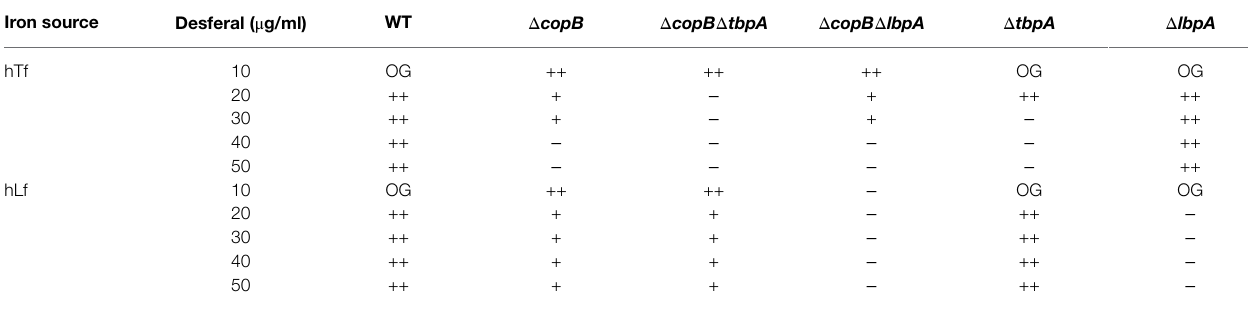
TABLE 3 | Human transferrin, hLf, and pTf utilization phenotypes of wild type and knockout strains. Iron